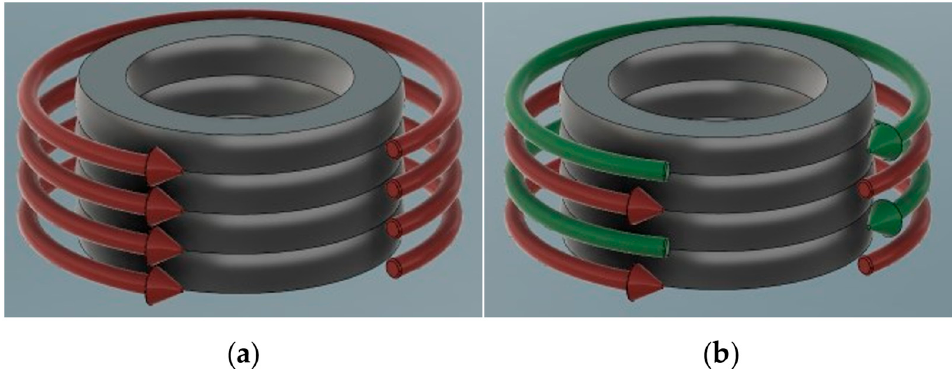
Figure 3. Goal of the G-Code post-processing. ( a ): Original perimeter directions (counterclockwise); ( b ): Perimeter directions after post-processing (alternating directions).